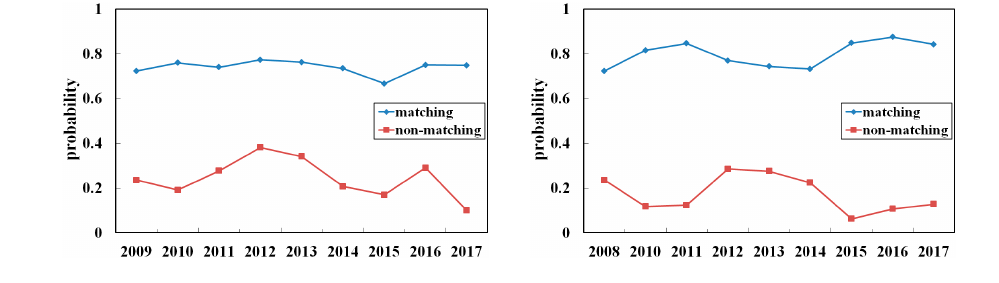
(a) Image in 2008 as reference image. (b) Image in 2009 as reference image. Figure 4. Cont